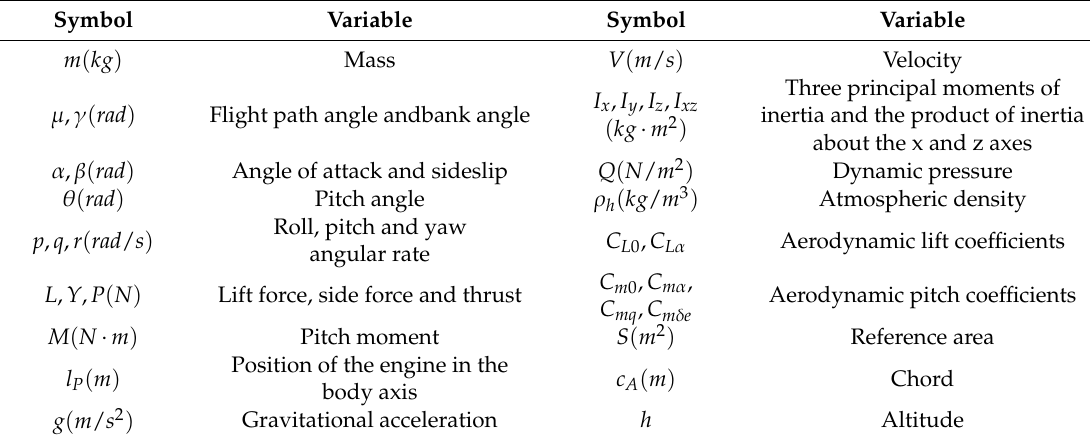
Table 1. Main notations and